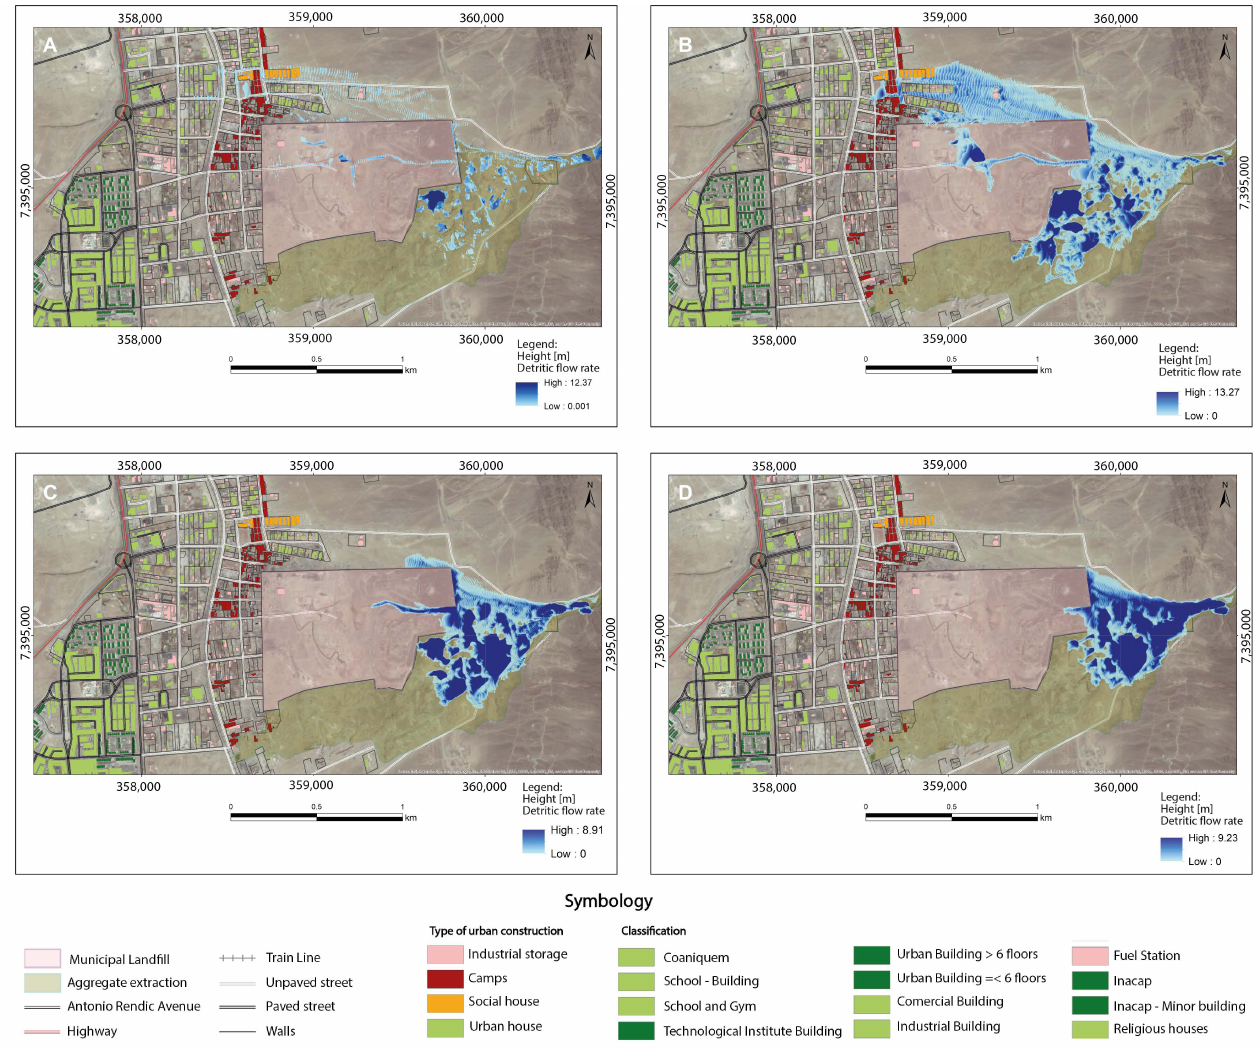
Figure 7. Debris flow impact maps for the La Chimba basin. Results of the mathematical modeling of the HEC-RAS software ( A ), RAMMS software for maximum fluidity ( B ), medium fluidity ( C ) and minimum fluidity ( D ) for a maximum debris flow of 110.29 m 3 in 1.5 h, representing the maximum intensity of the design event, with a return period of 200 years (Tr200) as the worst scenarios to represent. The red, orange, pink, dark green and light green colors represent from a materiality with null or almost null resistance to a high resistance to landslides such as flows. The bluish colors represent the maximum heights (meters) that debris flows can